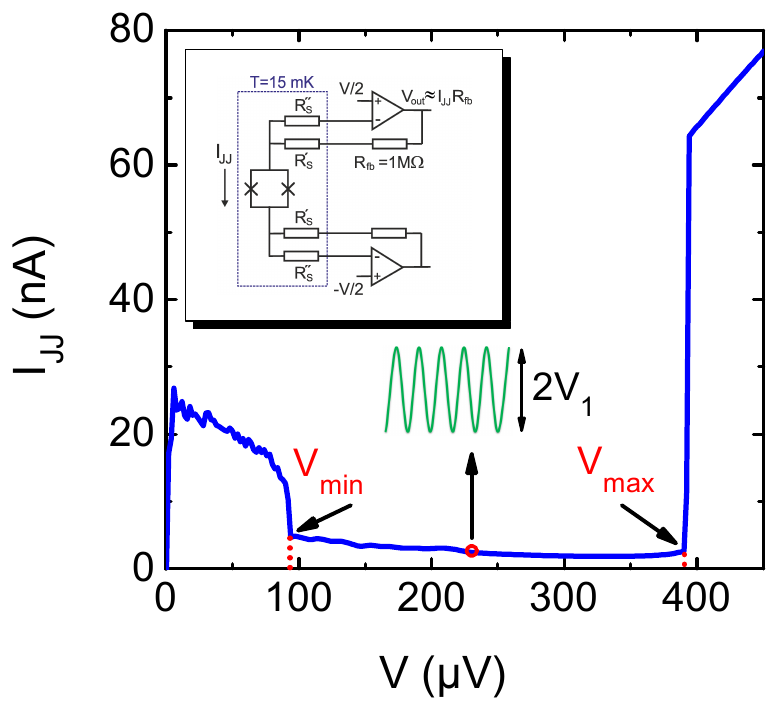
Figure 3. Measured I - V curve of the Josephson source at T ≈ 15mK and B = 0. The operating points of this device, used for microwave signal generation, lie in the voltage range 100 µV (cid:46) V (= V JJ ) (cid:46) 400 µV. Inset shows the equivalent biasing circuit for I - V curve measurement employing a transimpedance